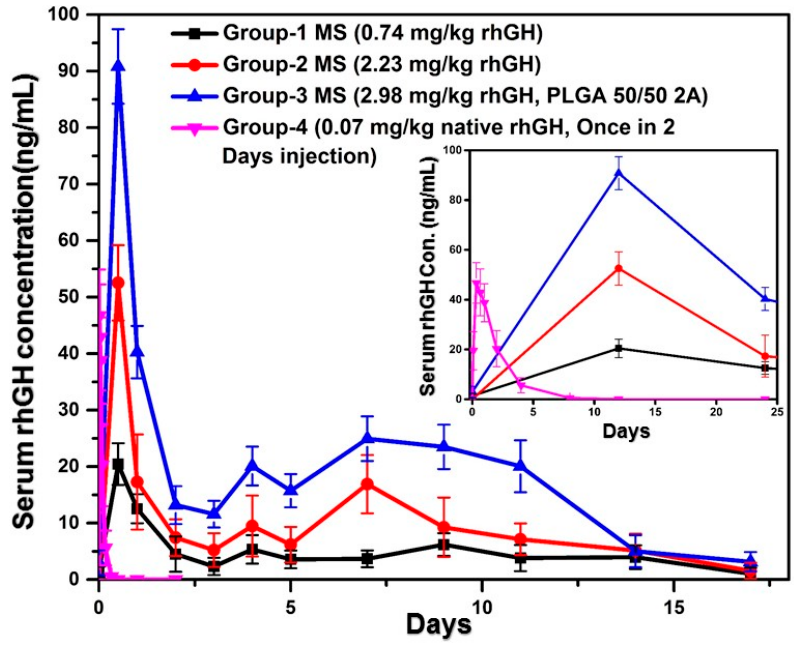
Figure 7. Serum concentration of rhGH after single subcutaneous injection of different treatments ( n = 5, p < 0.05). Table 1. Pharmakokinetic studies on group-1 (0.744 mg / kg rhGH), group-2 (2.23 mg / kg rhGH),